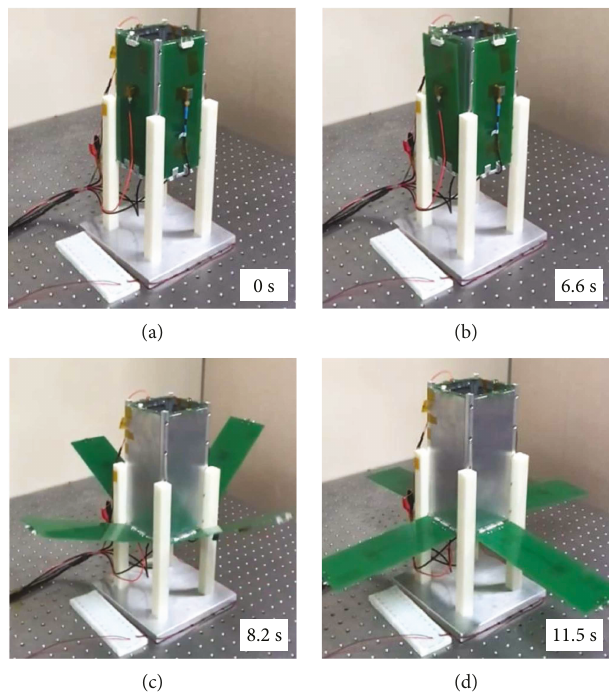
Figure 7: Example of a successful release sequence of the